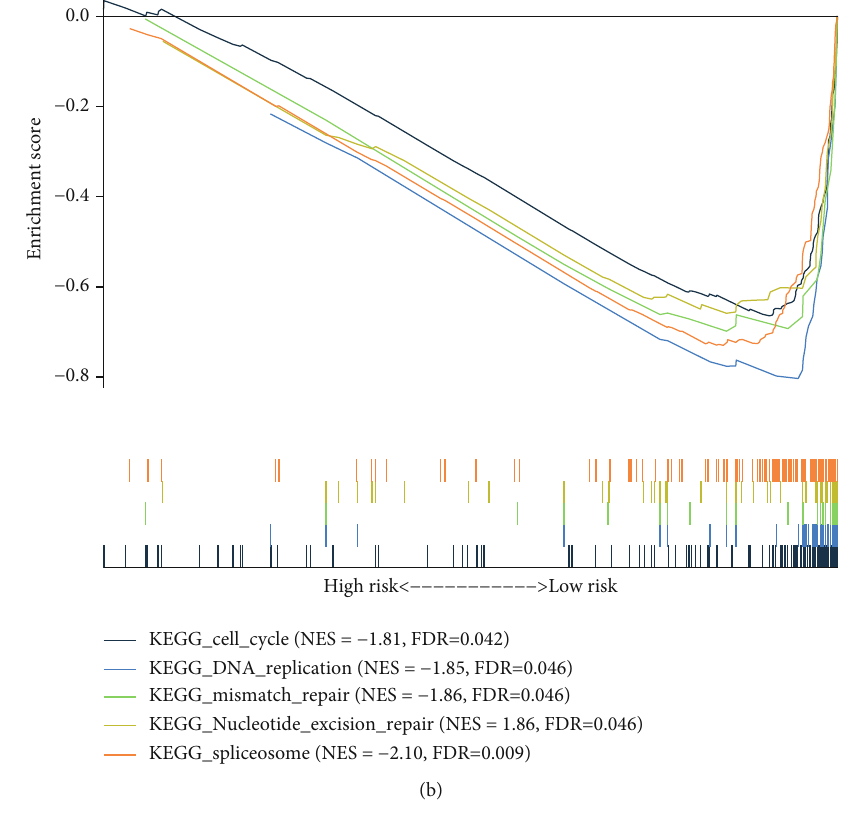
Figure 10: GSEA of the whole TCGA set: (a) enriched pathways in high-risk patients; (b) enriched pathways in low-risk